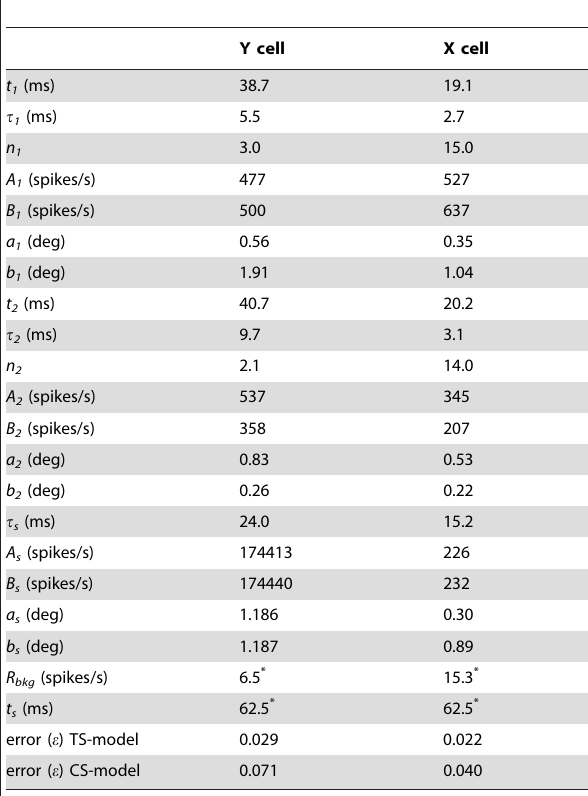
Table 1. Best-fit parameters from fitting the transient- sustained (TS) model in Eq. (14) to response data for example Y and X cells, cf. Fig.